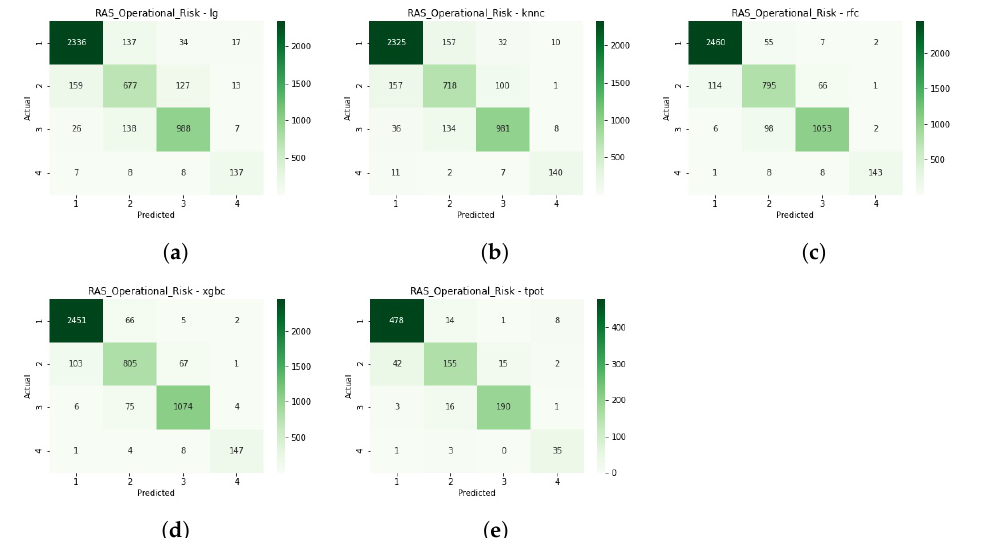
Figure A6. Operational risk: confusion matrices generated when evaluating the above-mentioned models, using cross-validation approach. ( a ) Logistic Regression. ( b ) k-Nearest Neighbours clas- sifier. ( c ) Random Forest classifier. ( d ) Extreme Gradient Boosting classifier. ( e ) TPOT classifier autoML